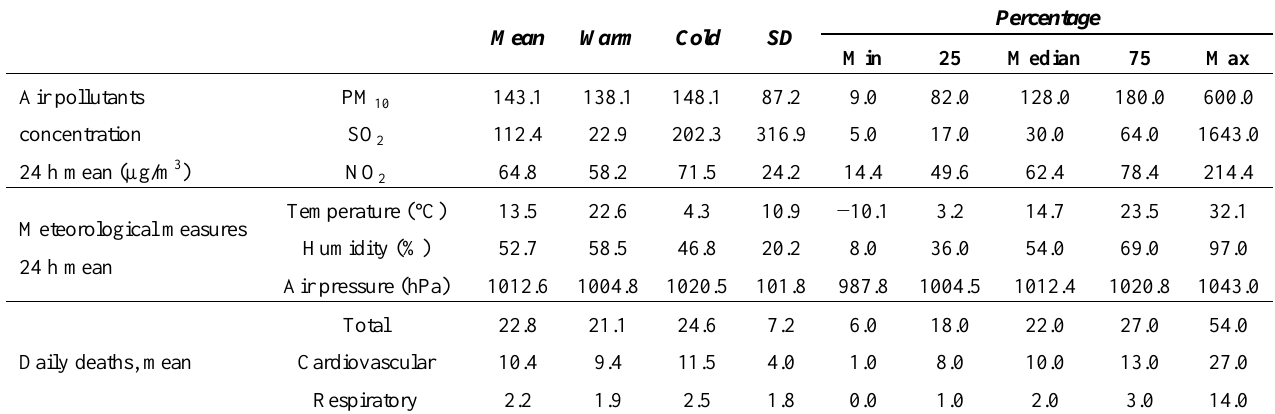
Table 1. Daily pollutant concentrations, meteorological factors and numbers of